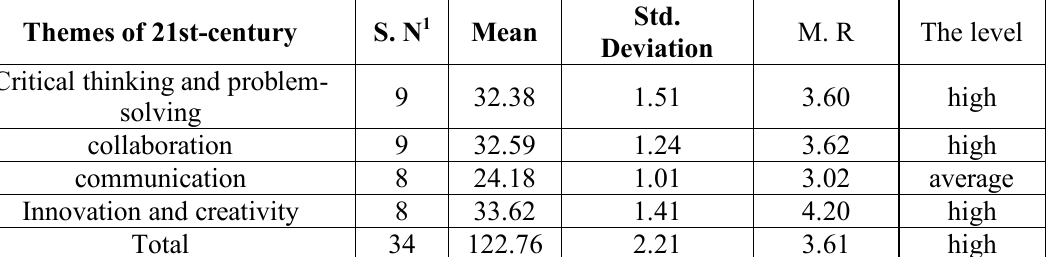
high 1 S. N= number of statements in the dimension Mean of response (M.R) = Mean ÷S.N Source: own